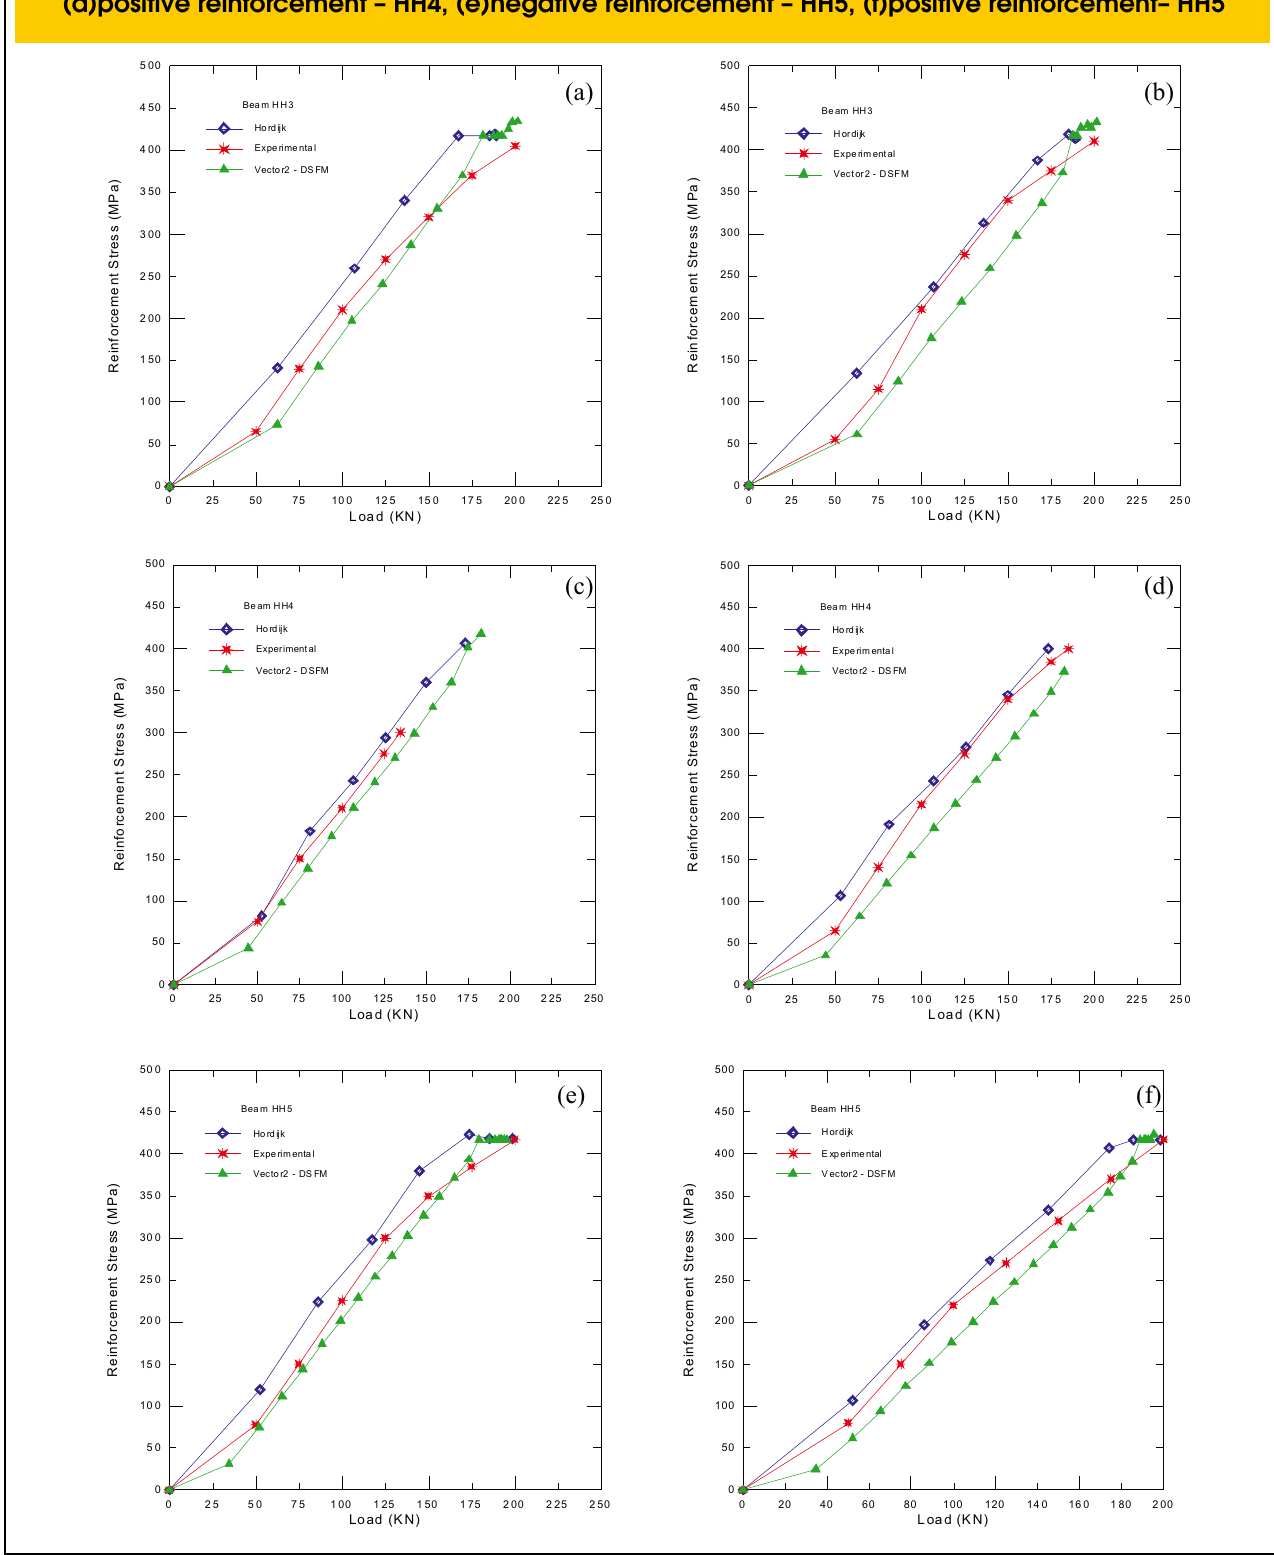
Figure 14 – Reinforcement Stresses (HH3, HH4 and